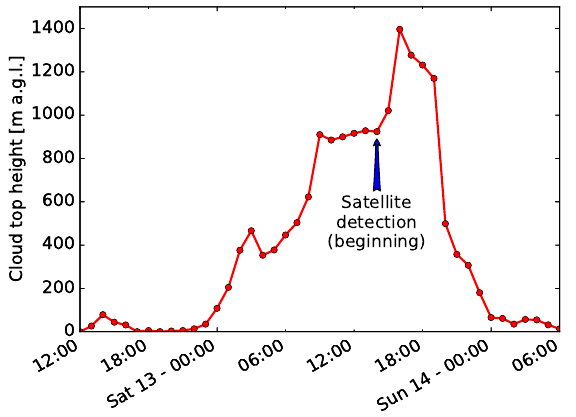
Figure 14. Time series for the cloud top height (defined as the max- imum height at which a concentration of 1mgm − 3 is attained) over the Fiambalá Basin. Data are averaged over the FALL3D fine do- main (28–27 ◦ S and 68–67.3 ◦ W). A significant increase in cloud height occurs between 14:00 and 15:00UTC, coinciding with the onset of dust detection by satellite (blue arrow).